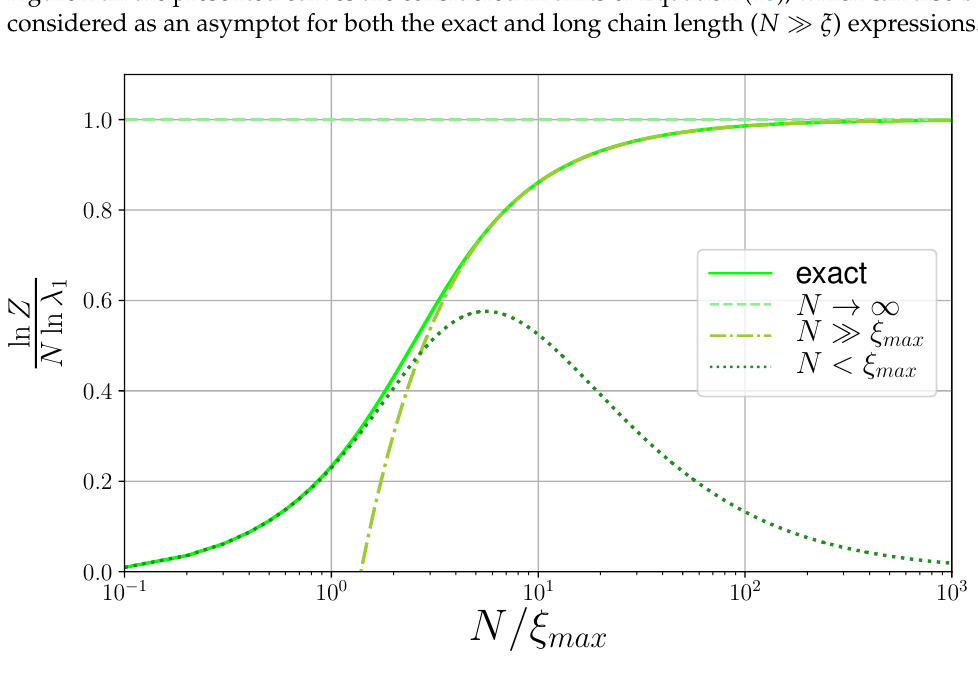
Figure 2. Limits of partition function of the Zimm–Bragg model and their size-scaling behavior. Partition function is in logarithmic units and is reduces to the infinite chain approximation; chain length is reduced to the correlation length and is plotted in logarithmic scale. All plotted formulas are at transition point s ∗ = 1 2 σ ; σ = 0.001, resulting in ξ max = 15.8. Legend is shown as the −